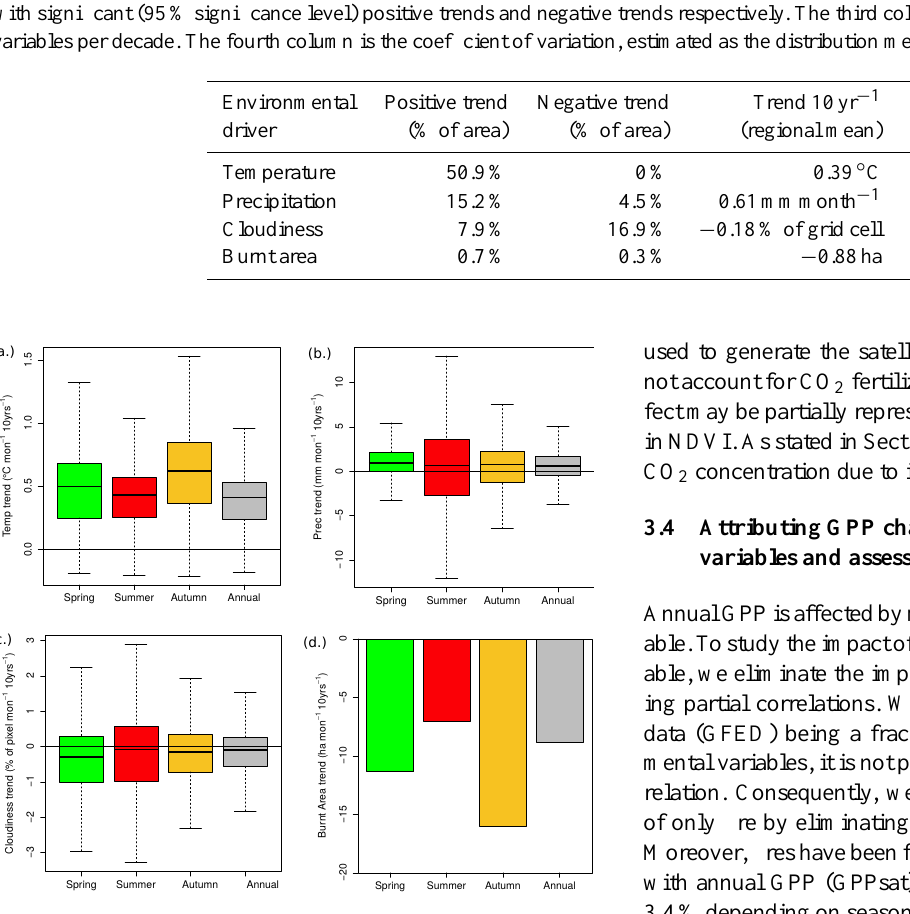
Figure 6. Change in the environmental variables over the period of study represented by seasonal trends. Panels (a–c) show distribu- tion of 2m air temperature, precipitation, and cloud cover respec- tively for the period 1982–2010, and panel (d) illustrates seasonal trends of total burnt area for the period 1997–2011. The tempera- ture, precipitation, and cloud cover data are taken from the Climatic Research Unit (CRU TS 3.21) data set (Harris et al., 2014). Burnt area data from the Global Fire Emissions Database (GFED; Giglio et al.,